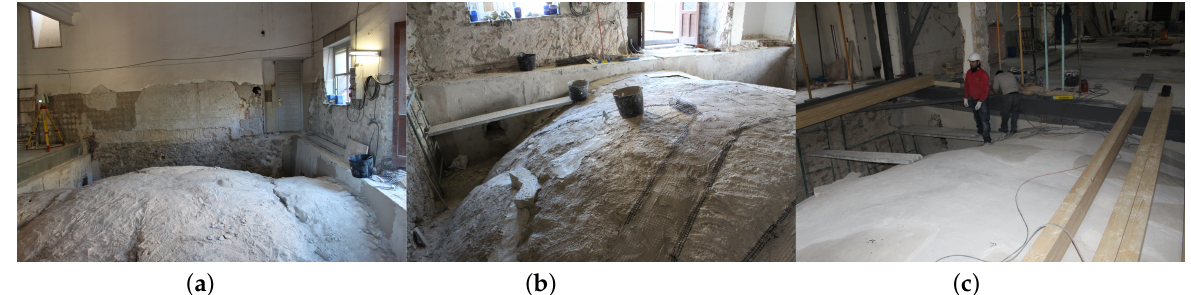
Figure 8. Principal vault extrados on its different restoration states: ( a ) Original ( b ) Reinforcement application on nerves ( c )